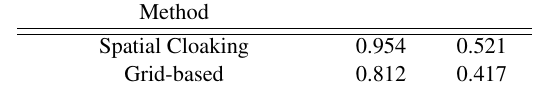
Table 3: Pearson’s correlation coefficients for various methods and on different levels of the accuracy.